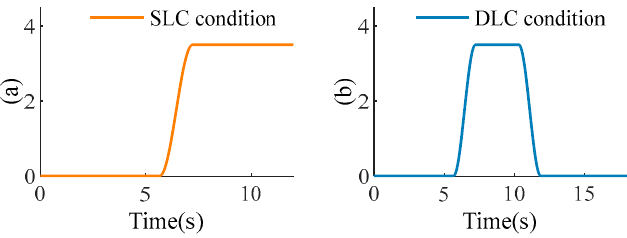
Figure 7. System control flow of hardware-in-loop experiment.